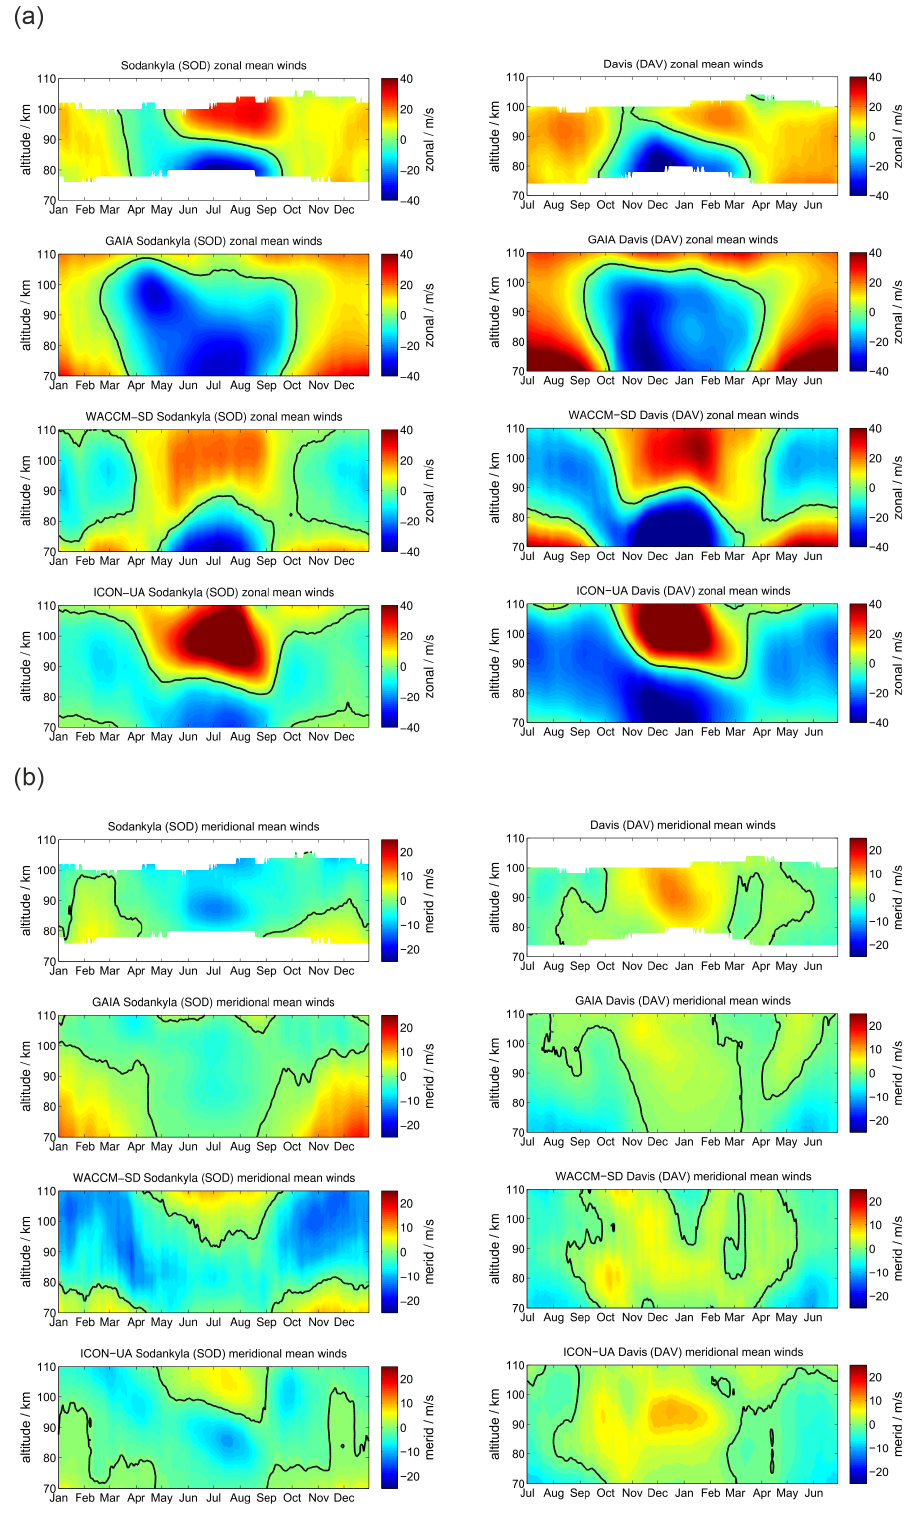
Figure 2. Comparison of zonal (a) and meridional (b) daily mean winds for the MRs at SOD (left column) and DAV (right column). The winds for Davis are shifted by half a